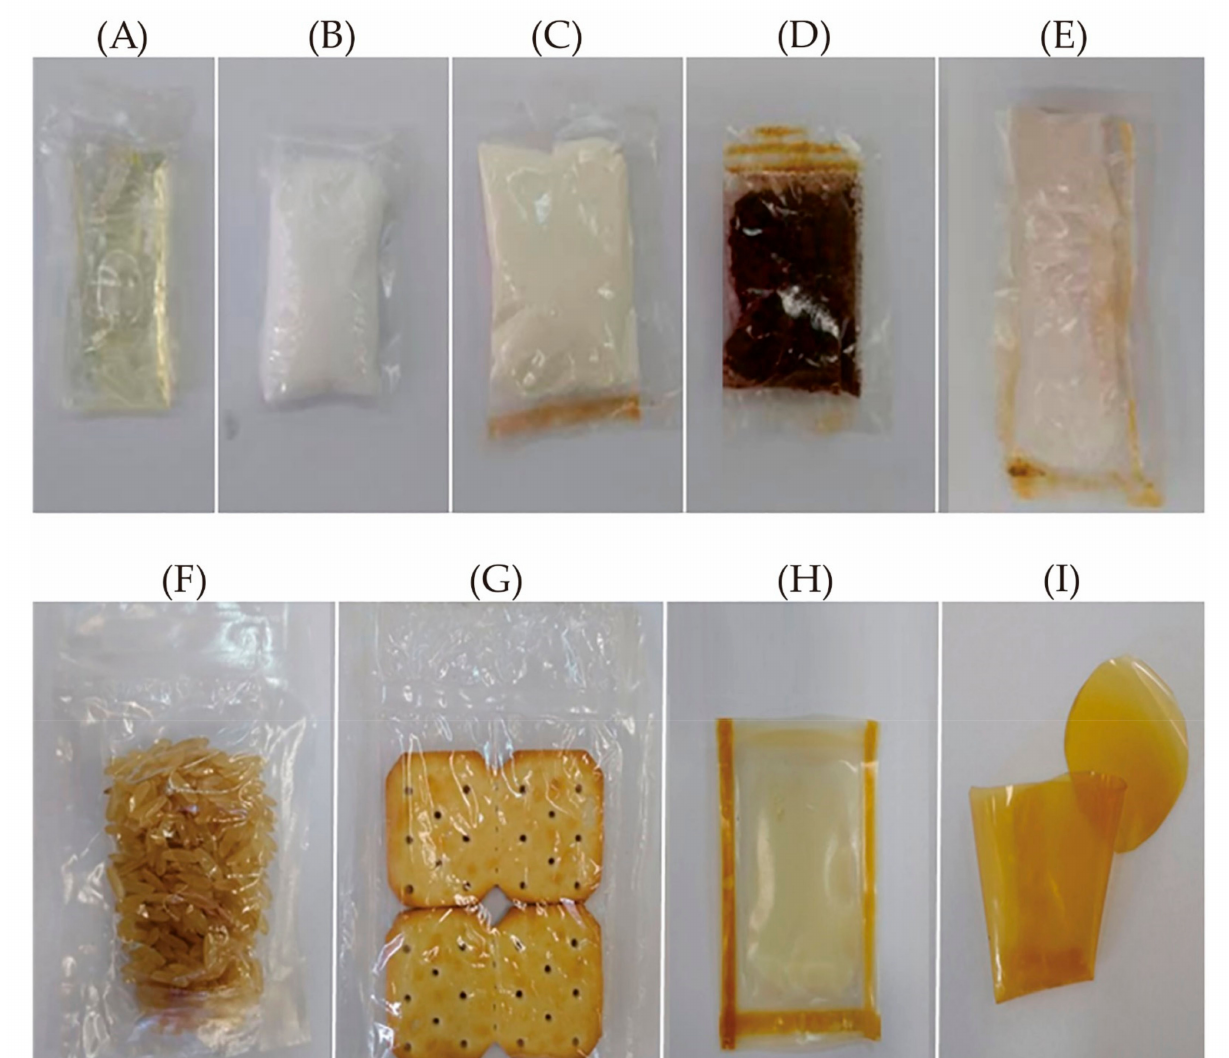
Figure 6. Prototype photos of different edible packaging. From ( A – G ) are methylcellulose sachets containing soybean oil, salt, whey protein, powdered coffee, powdered juice, rice, and cookies, respectively; ( H ) Whey protein/methylcellulose edible sachet containing oil; ( I ) Whey protein edible film for the coffee capsule. (Reproduced with permission from Filipini [91]; published by John Wiley and Sons,